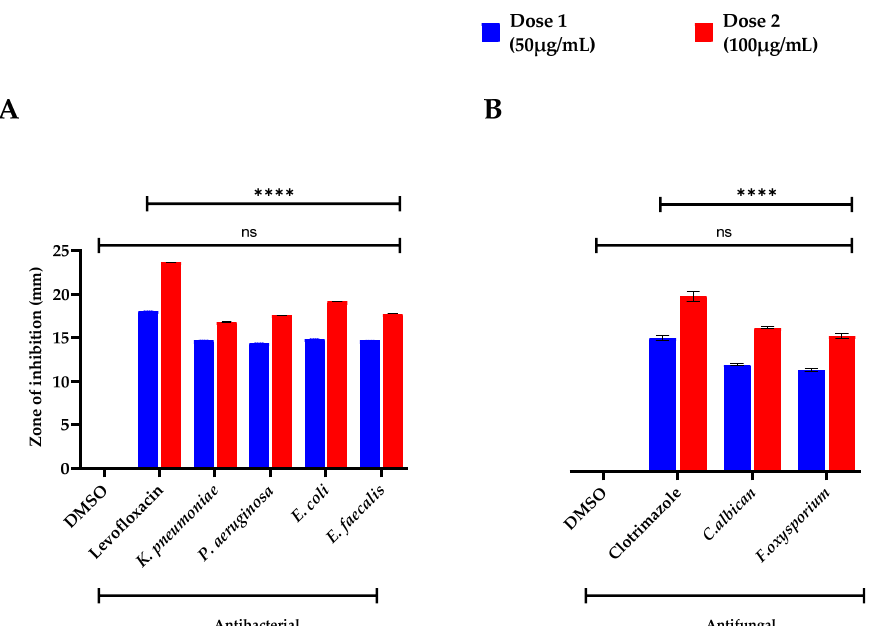
Figure 3. ( A ) Antibacterial and ( B ) antifungal zone of inhibitions of oil of S. edelbergii . DMSO = negative control, Levofloxacin and Clotrimazole = positive control. Data were taken in triplicate ( n = 3) and analyzed through two-way ANOVA, via Sidak’s multiple comparison test, ns = > 0.9999, **** p = <0.0001).